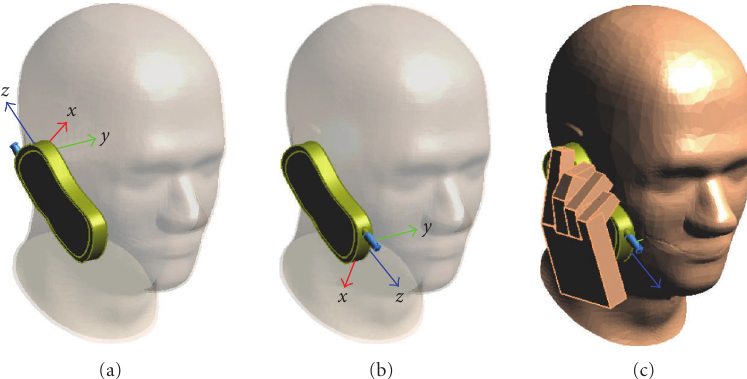
Figure 6: Coordinate system; (a) the handset model no. 1 referenced as seen from the right side of the SAM, at cheek position, (b) the handset model no. 2 referenced as seen from the right side of the SAM, at cheek position, and (c) the handset model no. 2 in hand close to SAM at cheek position.